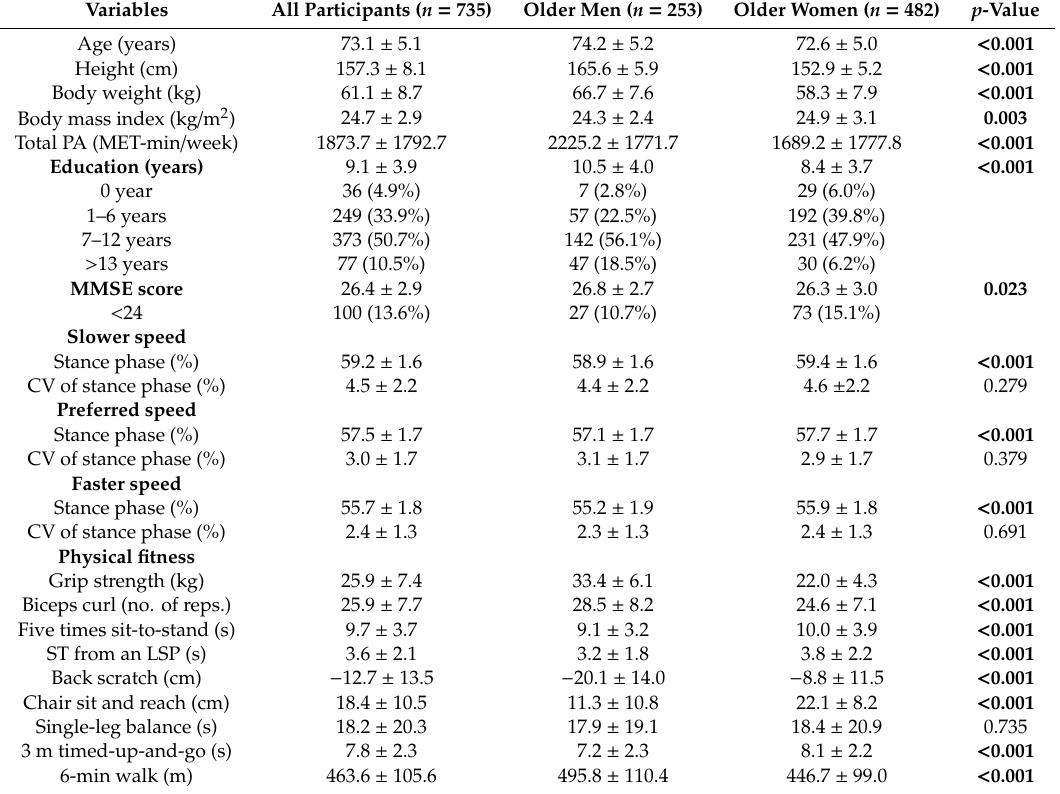
Table 1. Demographic, gait, and physical fitness characteristics of participants.